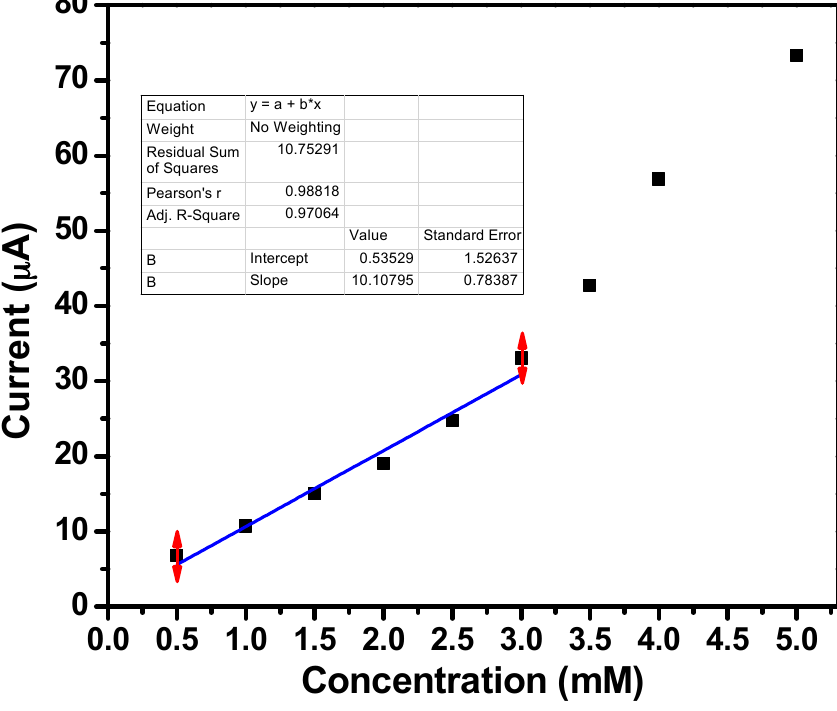
Figure 6. Calibration plot for ZnO nanoballs modified AgE towards acetone.